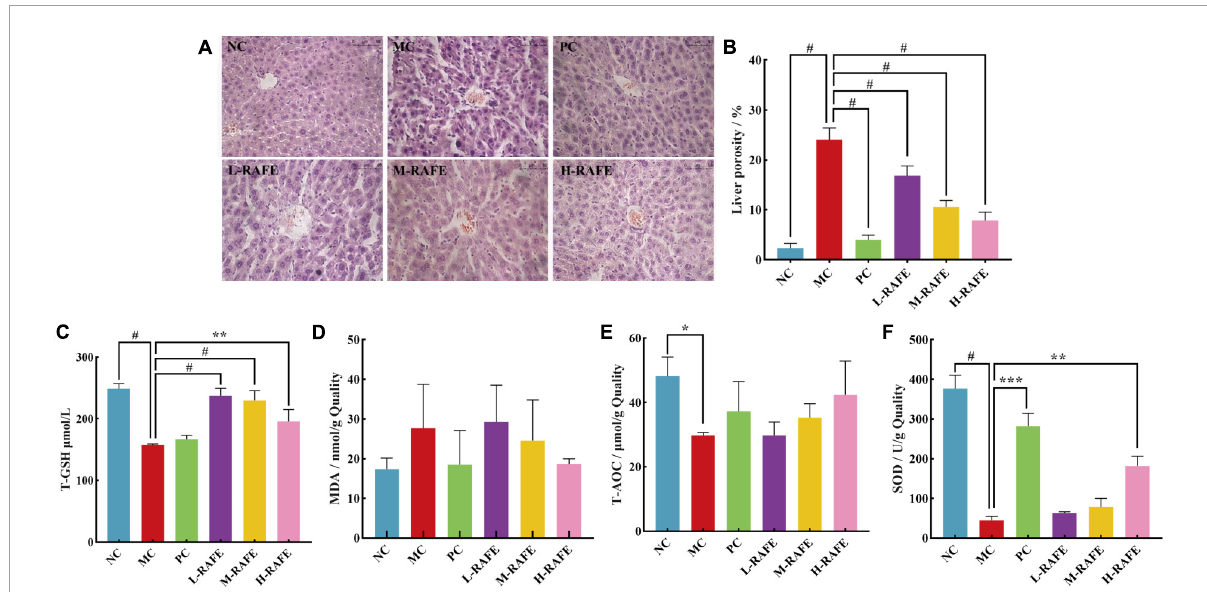
FIGURE5 Effect of RAFE on biochemical indexes of mouse livers and liver histology. (A) Histopathological observations of mouse livers (40 × magnification), (B) liver porosity, (C) T-GSH, (D) MDA, (E) T-AOC, and (F) SOD. Data are expressed as the mean ± SD ( n = 4 or 6) * P < 0.05, ** P < 0.01, *** P < 0.001, # P < 0.0001, compared with the pathological